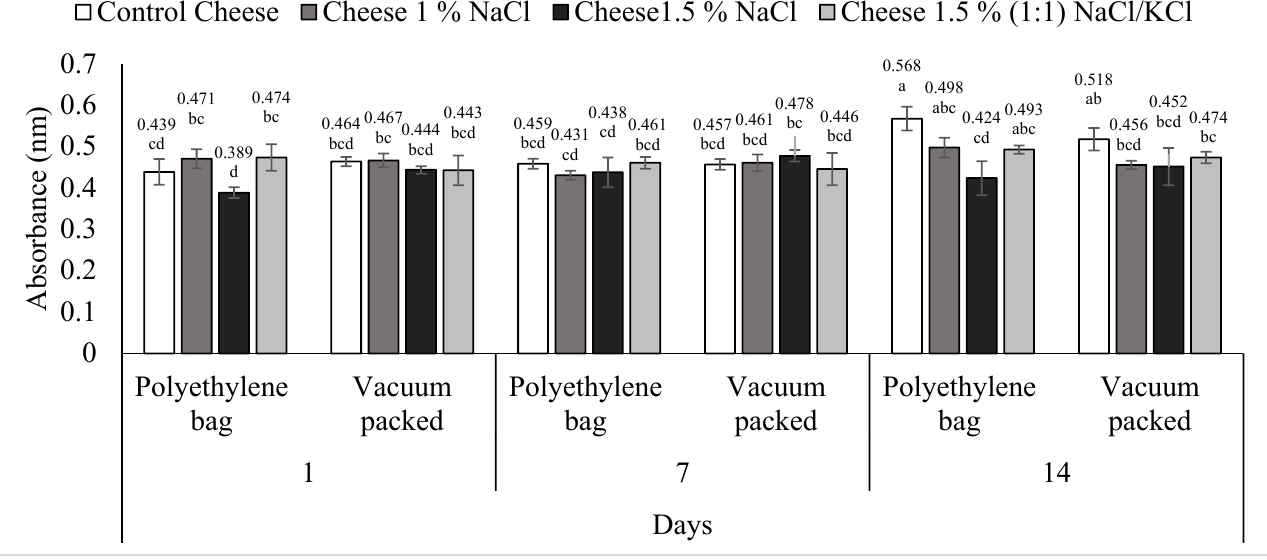
Figure 3. Proteolysis of requeson cheese with different salt type and concentration treatments, conventional and vacuum packaging. a–d Values with a different superscript indicate significant statistical difference ( p < 0.05). Table 1. Correlation between response variables of T1 requeson cheese (Control).